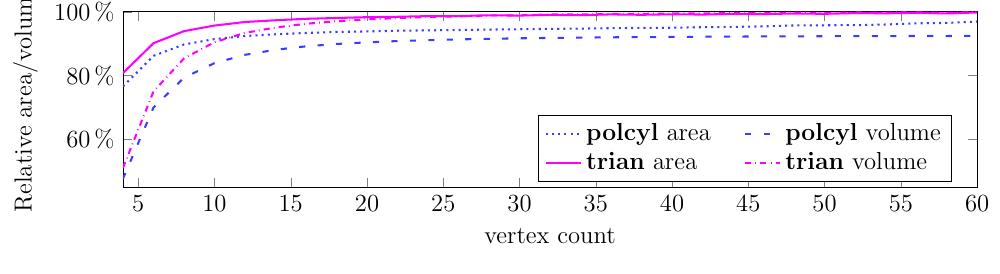
Figure 9. Effect of vertex count on polcyl and trian .